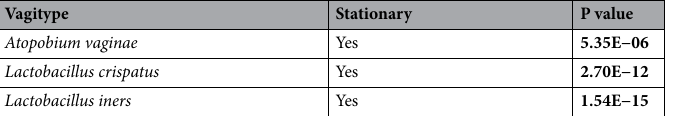
Table 2. Index of stability from augmented Dickey Fullers test. Significant p-values are depicted in bold face.